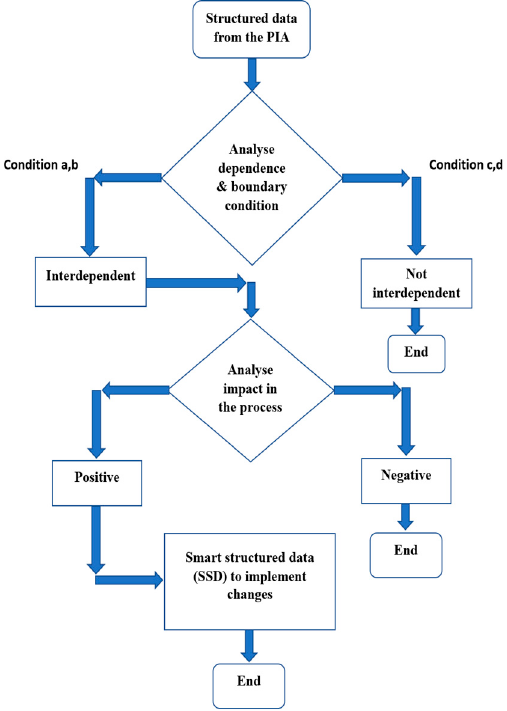
Figure 2. Data filtration process of the KHB methods.